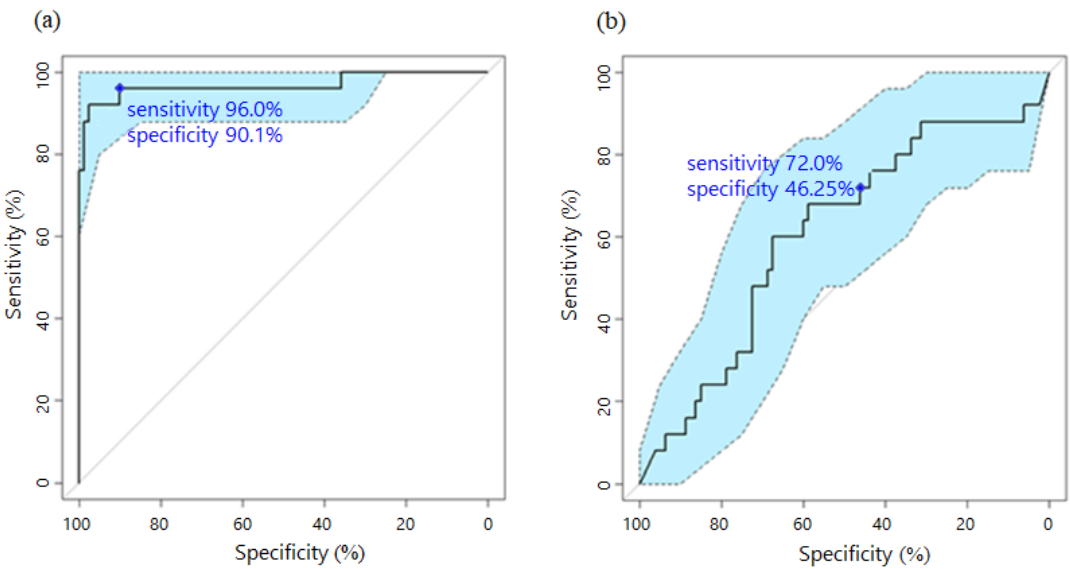
Figure 4. Receiver-operating characteristic (ROC) curve for pancreatic cancer (PC) diagnosis based on the proposed model and CA19-9. For validation, 25 PC samples and 81 intrahepatic cholangiocarcinoma samples were used to apply the ( a ) proposed model and ( b ) CA19-9 diagnosis. The confidence band of the ROC curve is indicated in light blue. The blue point represents the sensitivity and specificity based on the predefined threshold in each plot.